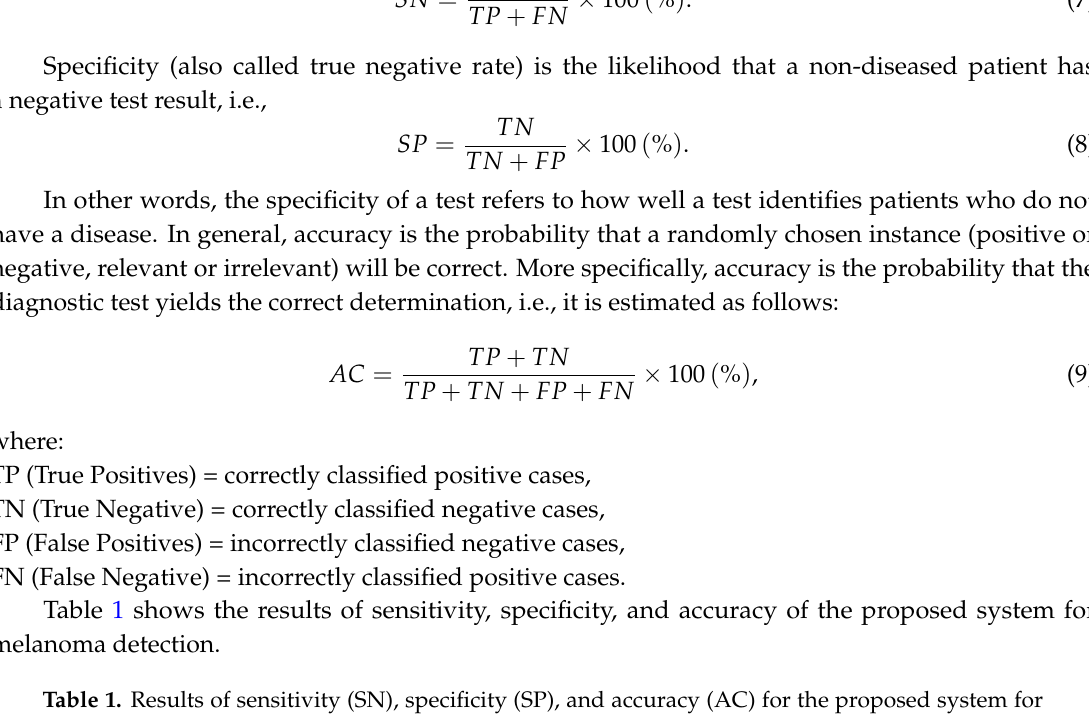
Table 1. Results of sensitivity (SN), specificity (SP), and accuracy (AC) for the proposed system for melanoma